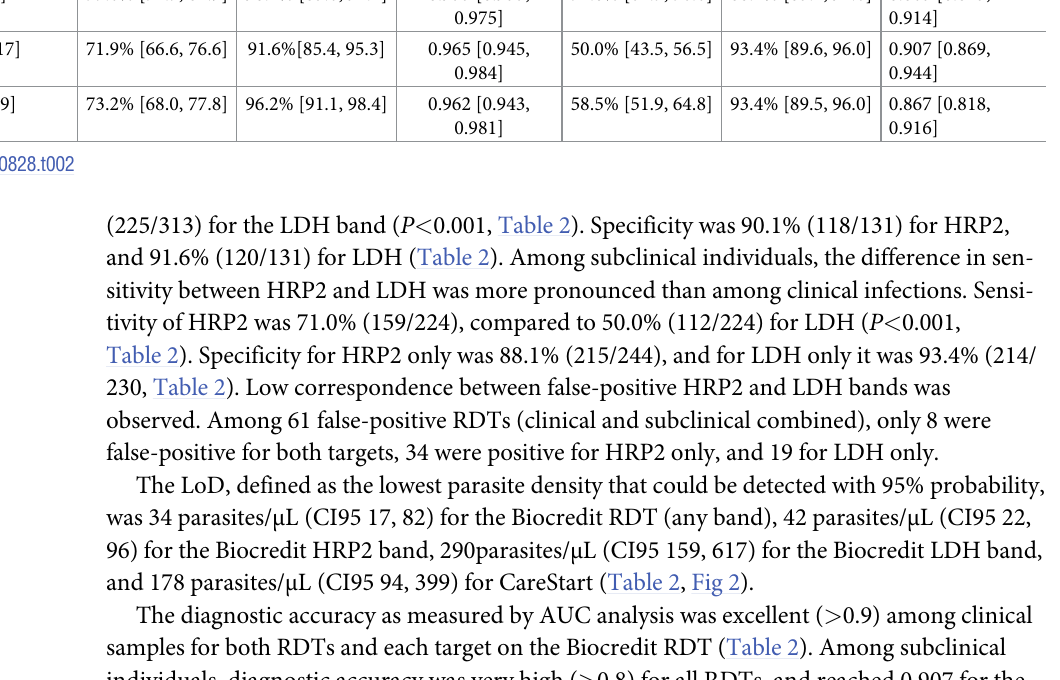
Table 2. Limit of detection, AUC, and sensitivity and specificity of RDTs as compared to qPCR.